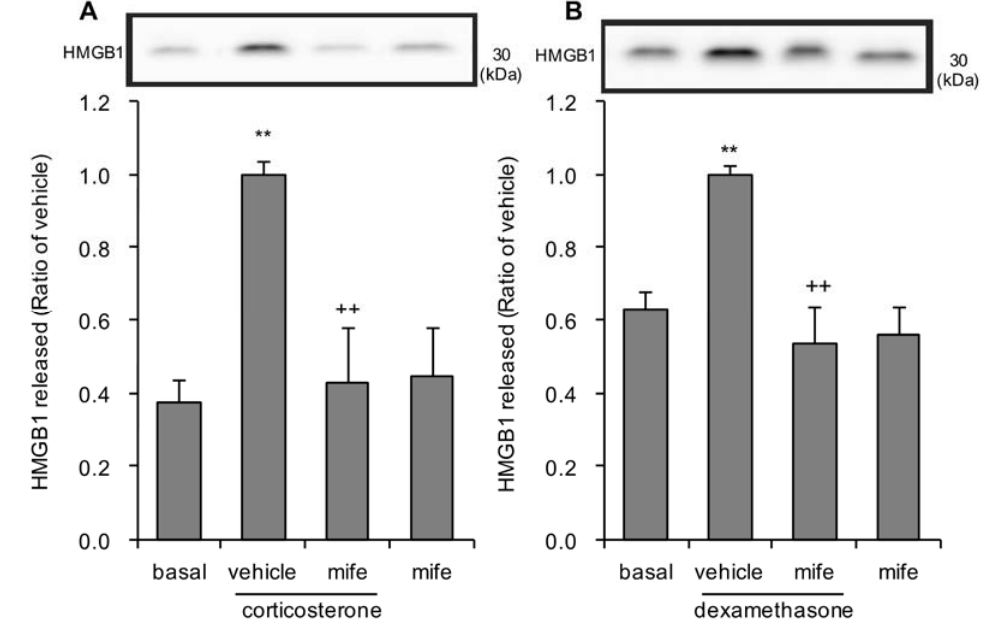
Figure 5. Effects of glucocorticoid receptor antagonist on corticosterone or dexamethasone ‐ induced HMGB1 release in primary cultured cortical astrocytes. ( A ) Astrocytes were pretreated with 0.5 μ M mifepristone (mife) for 30 min, and subsequently treated with 1 μ M corticosterone for 24 h. The amount of HMGB1 in the media was quantified by Western blotting. Representative blots are shown (HMGB1: 30 kDa). The data are expressed as the mean ± S.E.M. ** p < 0.01 vs. basal and ++ p < 0.01 vs.